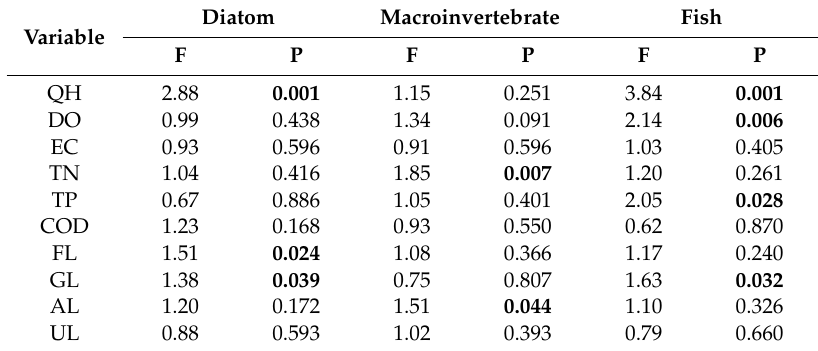
Table 3. Results of the Monte Carlo permutation tests in redundancy analysis (RDA) and canonical correspondence analysis (CCA).